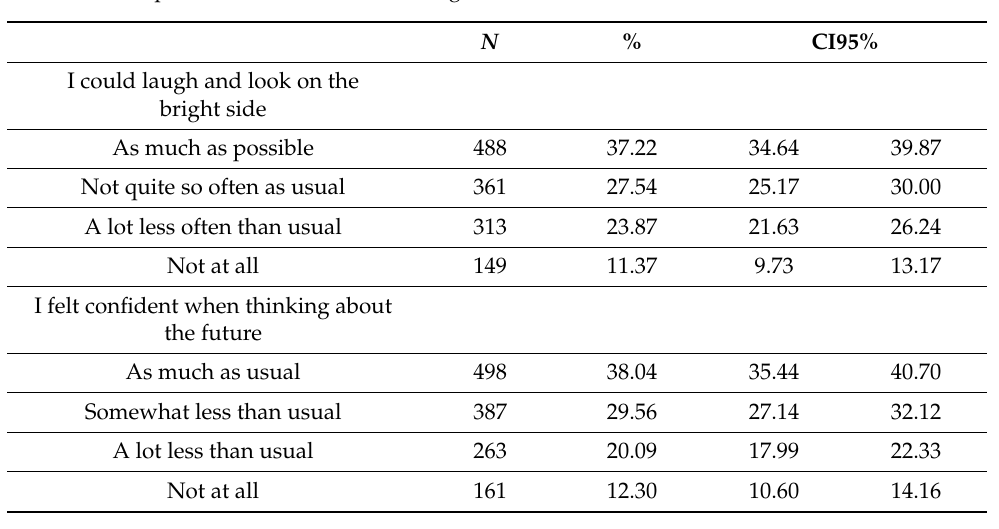
Table 2. Description of EDPS scores and